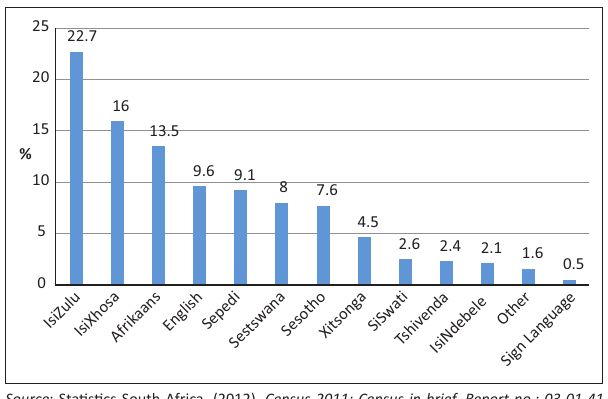
FIGURE 2: Distribution of languages spoken in South